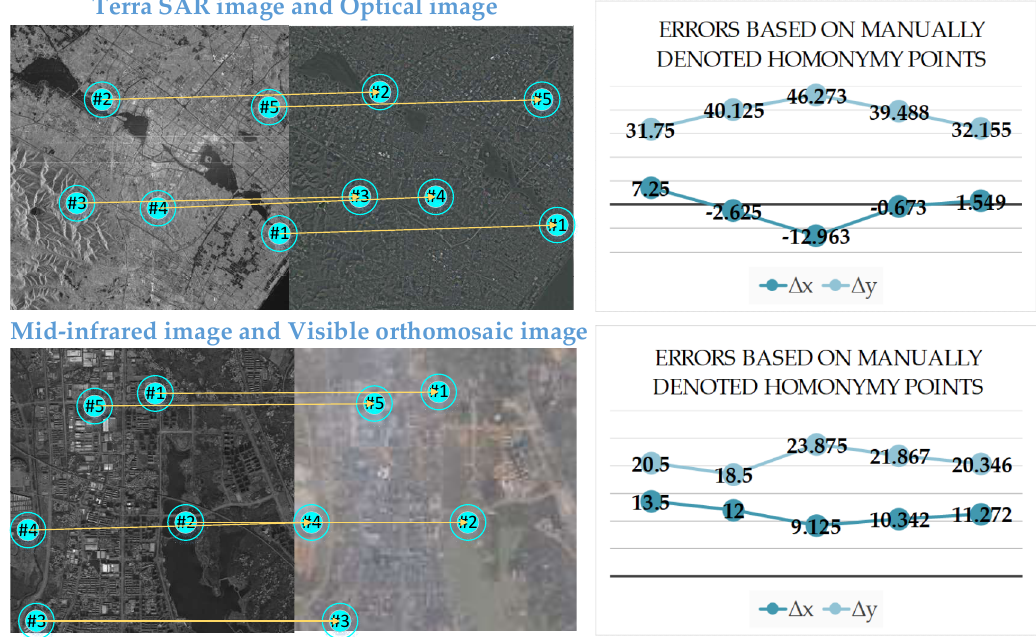
Figure 1. Non-uniform deformation of multimodal remote sensing image.